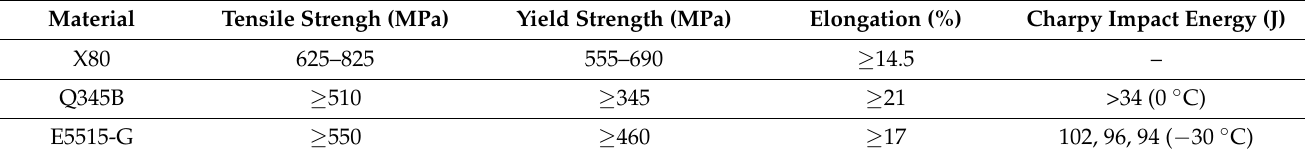
Figure 2. Microstructure of the base and sleeve pipe: ( a ) X80, ( b ) Q345B. Table 1. Chemical compositions (in wt%) of X80, Q345B and E5515-G deposited metal. The mechanical properties of X80 and deposited metal of E5515-G were listed in Ta- ble 2. Table 2. The mechanical properties of X80, Q345B and deposited metal of E5515-G.